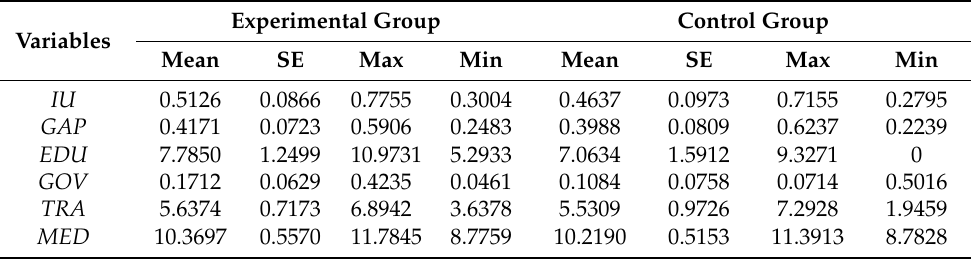
Table 1. Descriptive statistics. IU, in situ urbanization; GAP, urban–rural income gap; EDU, educa- tional resources; GOV, government support; TRA, traffic accessibility; MED, medical